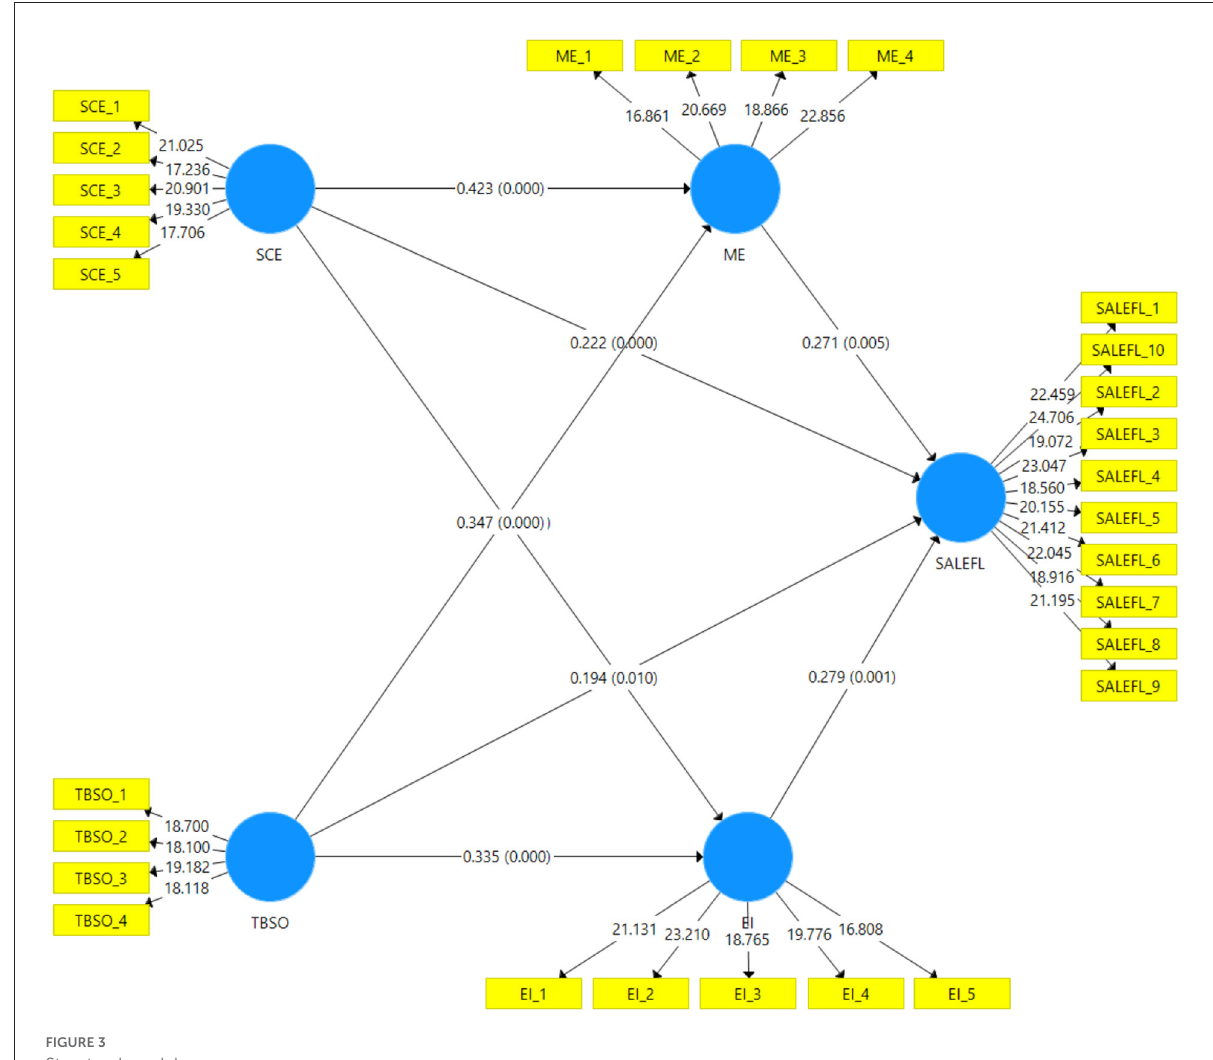
FIGURE3 Structural